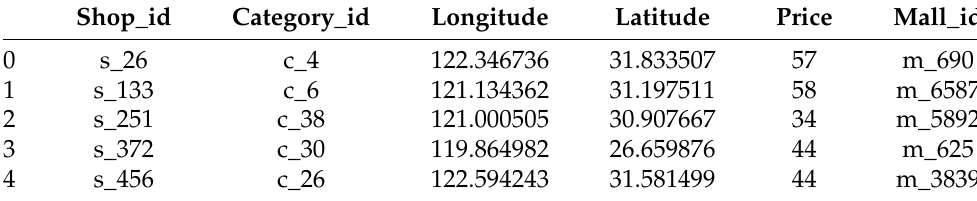
Table 1. Part of the shops’ information.